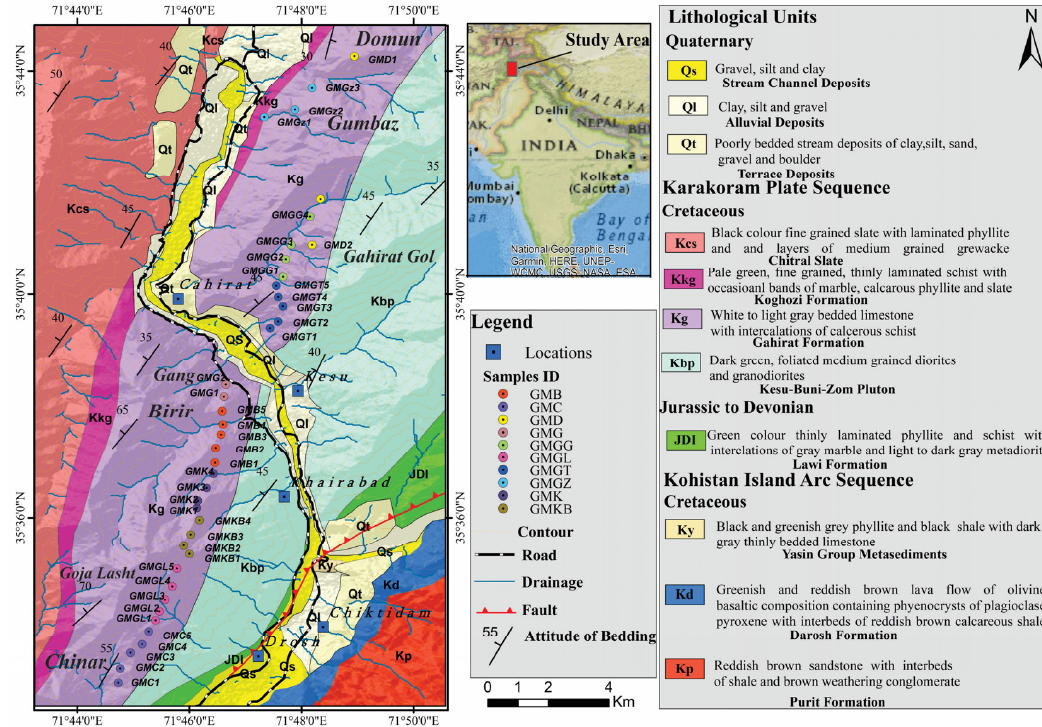
Figure 1. Geological and sample location map of the Chitral area.